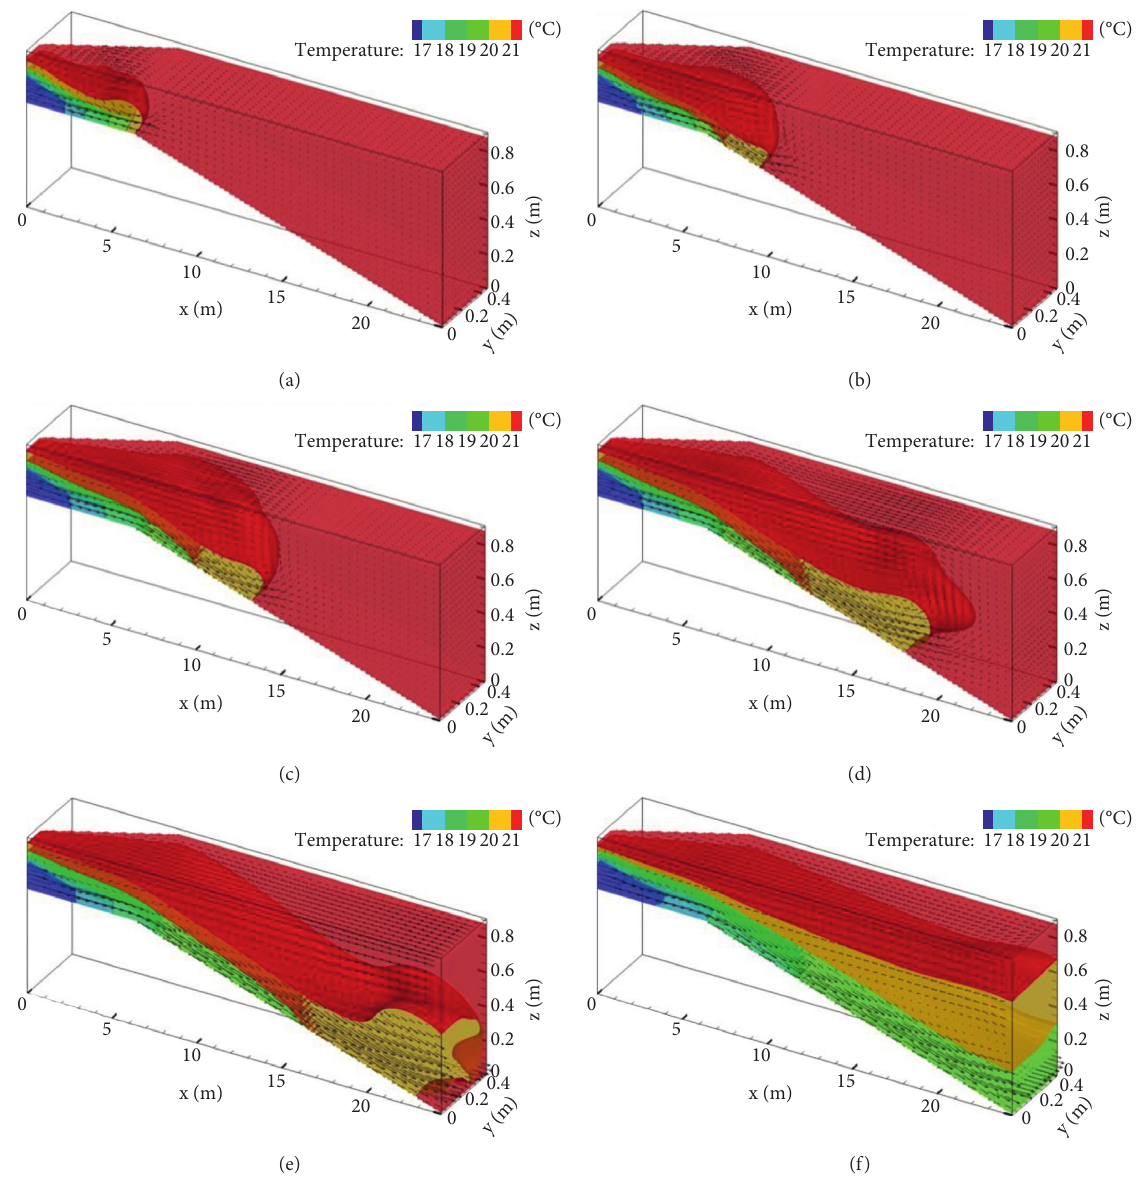
Figure 7: Isothermal surfaces distribution of the model reservoir at different times: (a) t � 4 min, (b) t � 8min, (c) t � 12 min, (d) t � 16min, (e) t � 20min, and (f) t �